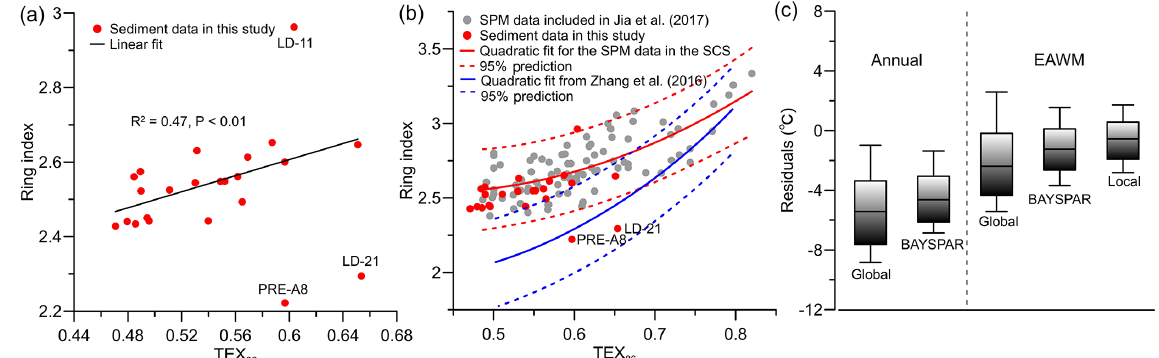
Figure 6. (a) Relationship of ring index (RI) with TEX 86 for surface sediments in this study (black line is the linear fit excluding the data of PRE-A8, LD-11, and LD-21); (b) RI vs. TEX 86 scatterplot for surface sediments in this study and surface water SPM from Jia et al. (2017); (c) box-and-whisker plot of annual residuals based on the global calibration (Kim et al., 2010) and BAYSPAR (Tierney and Tingley, 2014), as well as residuals relative to EAWM SSTs based on the global calibration, BAYSPAR, and a local calibration from winter SPM (Jia et al.,